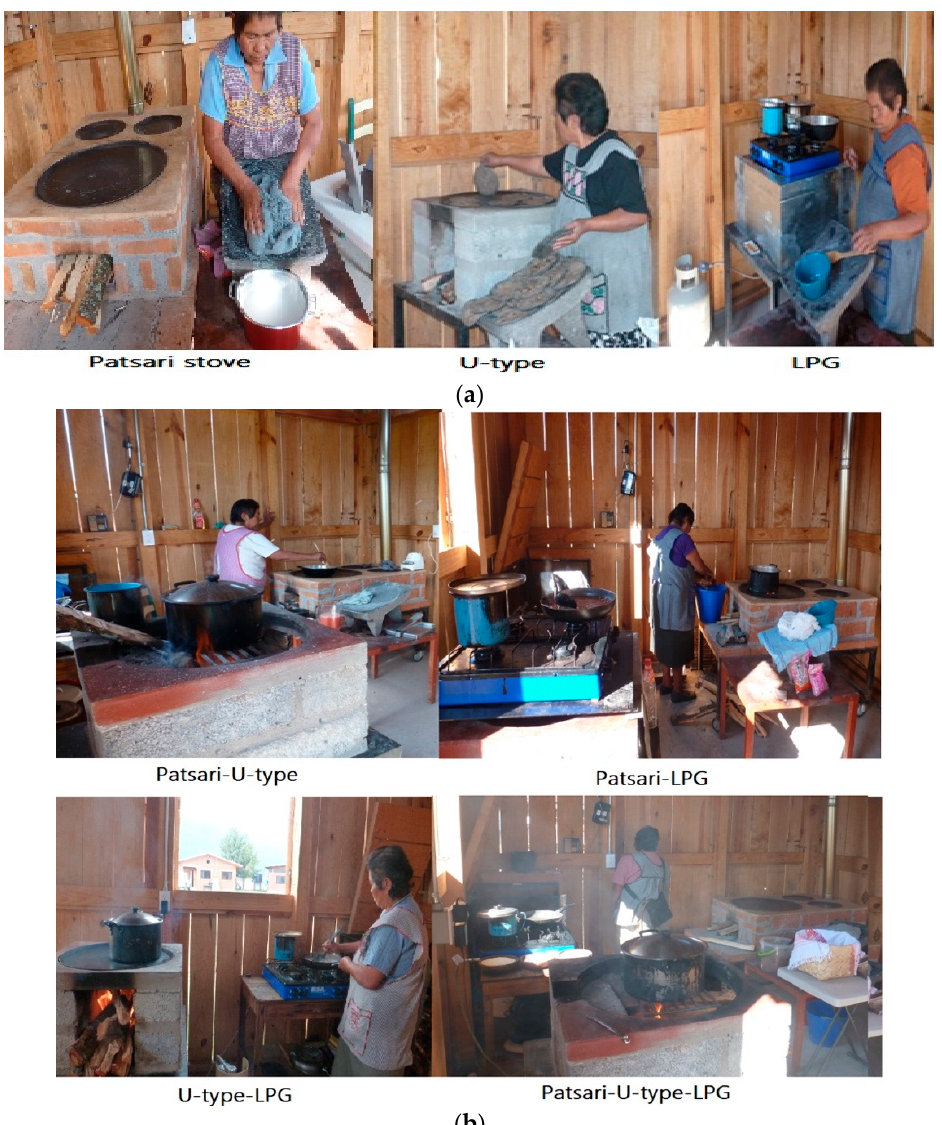
Figure 1. ( a ) Cookstoves tested: Patsari, U-type, and LPG. ( b ) Cookstove Stacking options. The Figure shows the cook conducting a controlled cooking cycle (CCC) in the simulated kitchen for each of the four combinations (stacking) of stoves tested: Patsari-U-type, Patsari-LPG, U-type-LPG, and Patsari- U-type-LPG. Table 1 describes the dishes that were prepared with each stove, depending on the stacking option. Table 1. Cooking tasks included in the CCC and their distribution according to each stacking option. Cooking